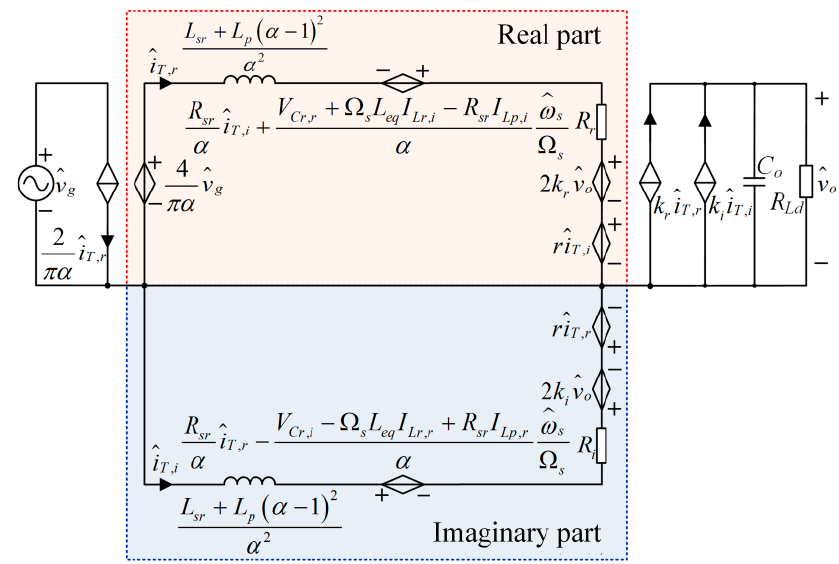
Figure 5. Third-order small-signal model of full-bridge LLC resonant converter.